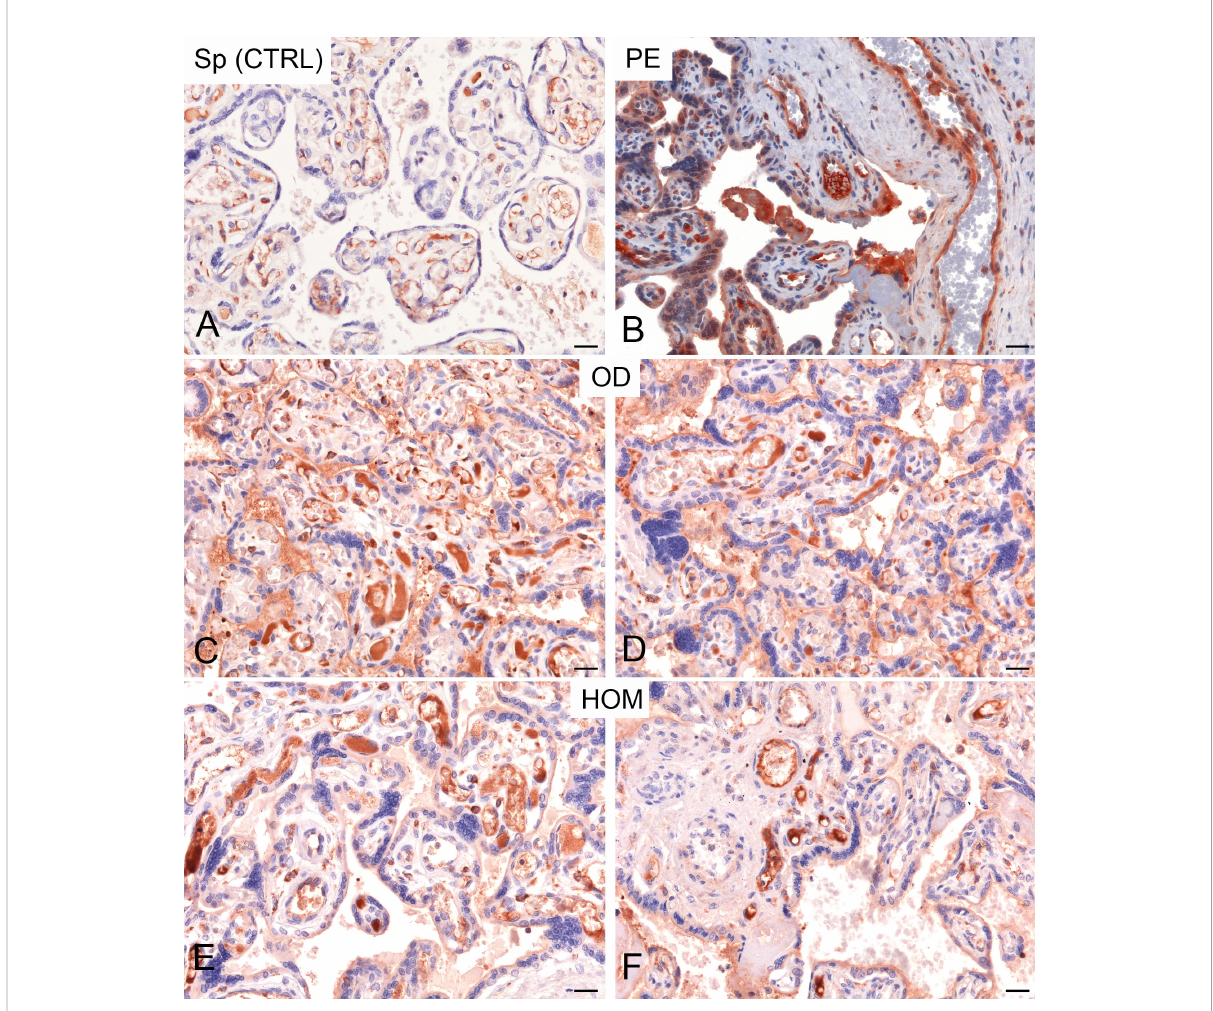
FIGURE 4 Immunohistochemical analysis of C1q in healthy pregnant women (CTRL) and pre-eclamptic (PE) placentae. Representative microphotographs showing a minimal staining for C1q in placentae derived from spontaneous pregnancies (Sp CTRL) (A) . In contrast, higher levels of C1q immunostaining were detected in PE placentae (B) . Interestingly, a high variability of C1q expression, but more similar to PE, was observed in placentae derived from oocyte donation pregnancies (OD) (C, D) and, less frequently, from homologous IVF pregnancies (HOM) (E, F) . AEC (red) chromogen was used to visualize the binding of anti-human C1q antibody. Scale bar 50